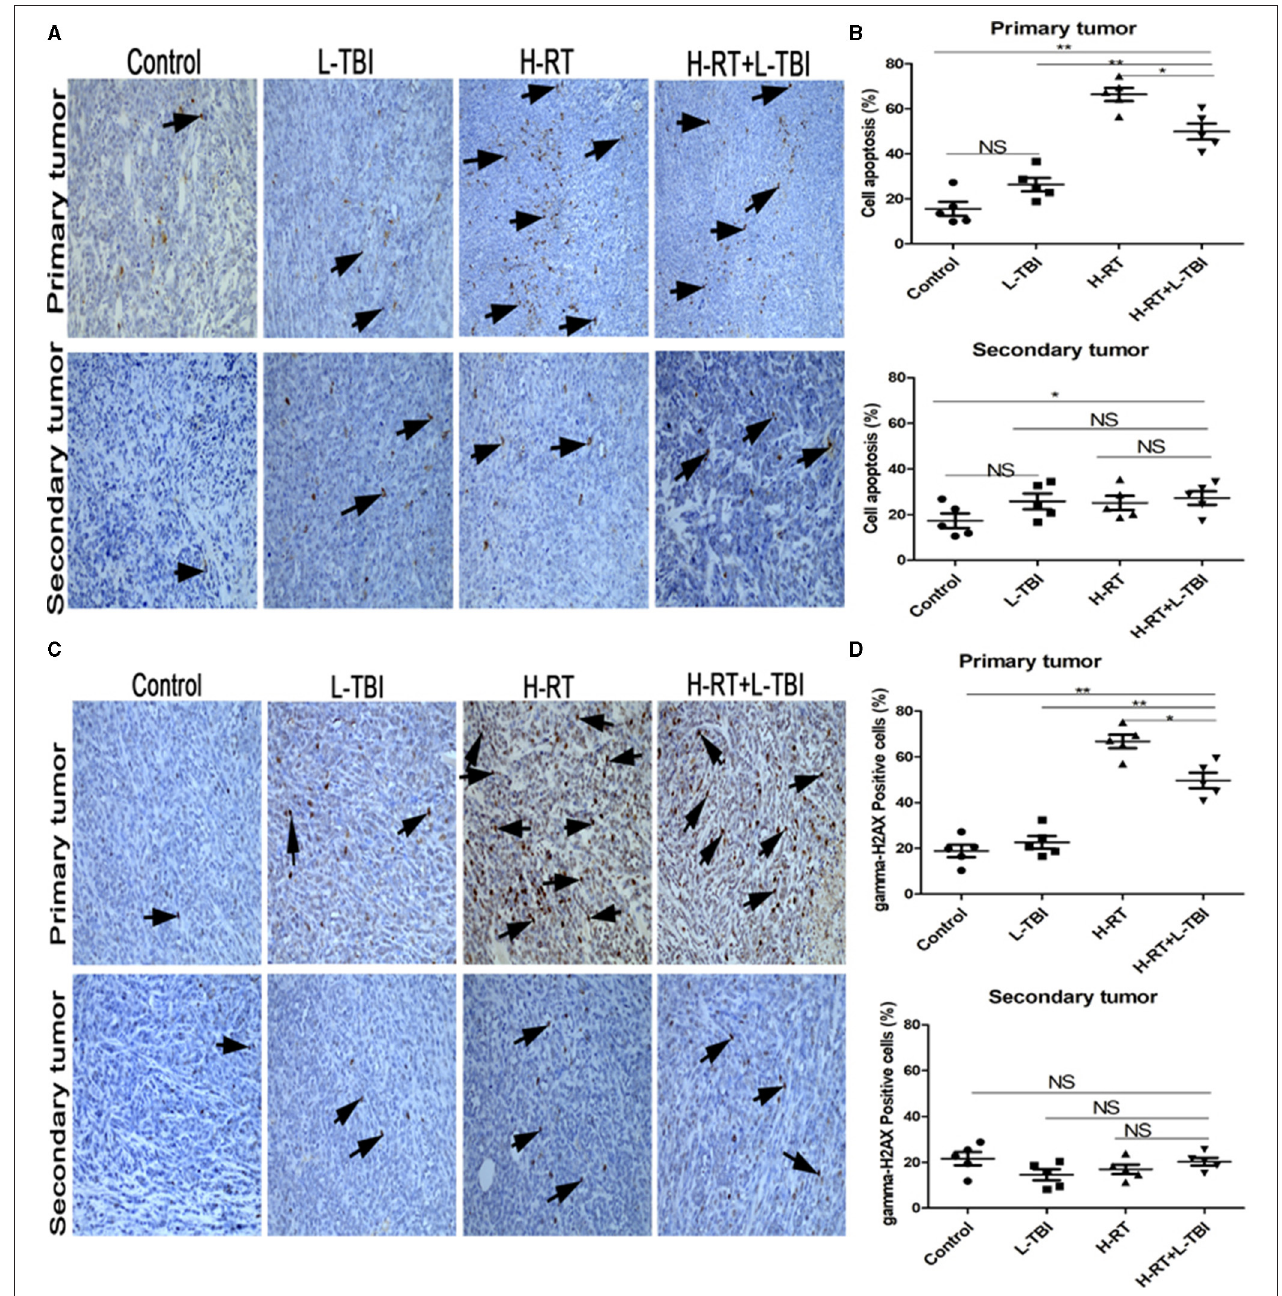
FIGURE 3 | Effect of combination H-RT and L-TBI therapy on apoptosis in 4T1 tumor-bearing tissues. (A) Comparison of representative TUNEL IHC-stained in different treatment groups. (B) Percentage of TUNEL positive cells in the primary and secondary tumor. (C) Representative gamma-H2AX IHC staining image in different treatment groups. (D) Percentage of gamma-H2AX positive cells in the primary and secondary tumor. The arrows point to the TUNEL and gamma-H2AX positive cells in the tumor tissue (original magnification × 200). Data are expressed as mean ± SE of 5 mice/group. (* P < 0.05, ** P < 0.01, and NS = not